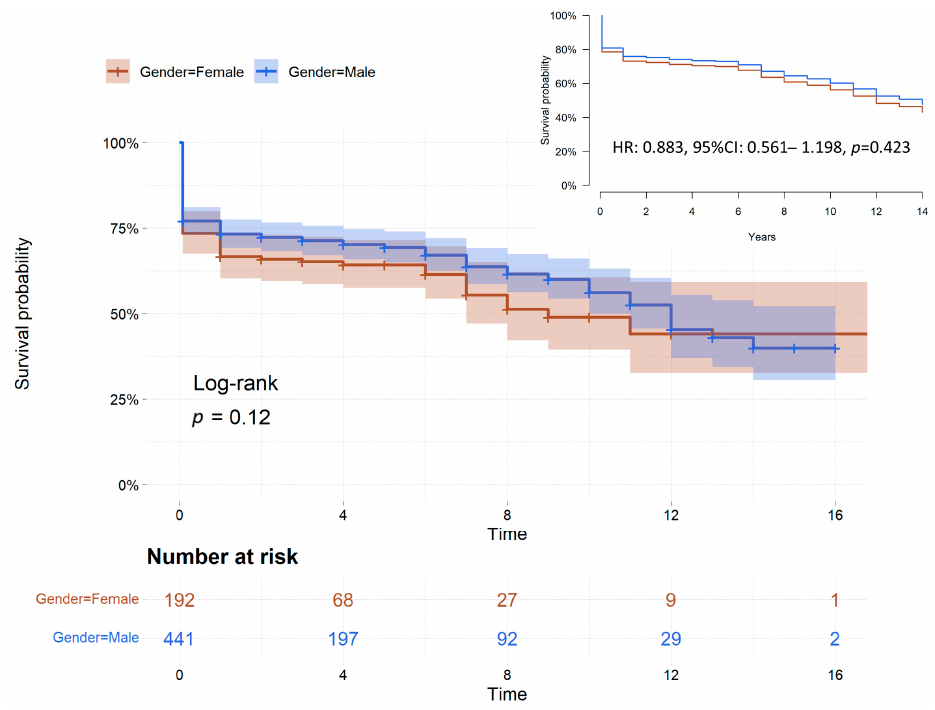
Figure 2. Kaplan–Meier survival curves stratified by gender and adjusted survival curves. CI, con fi dence interval; HR, hazard ratio.